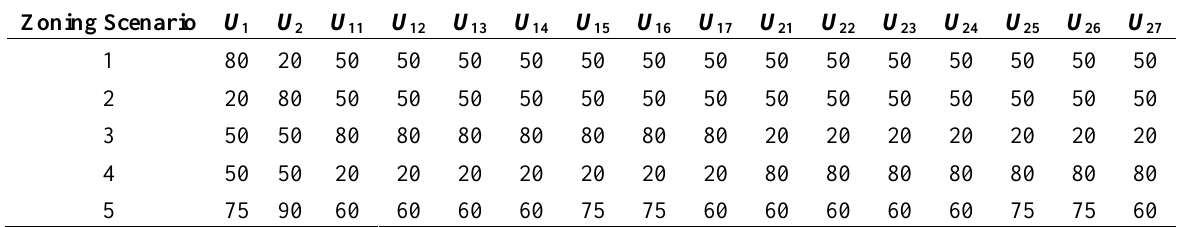
Table 7. Expected fitness values (%) of the optimisation objectives under different zoning